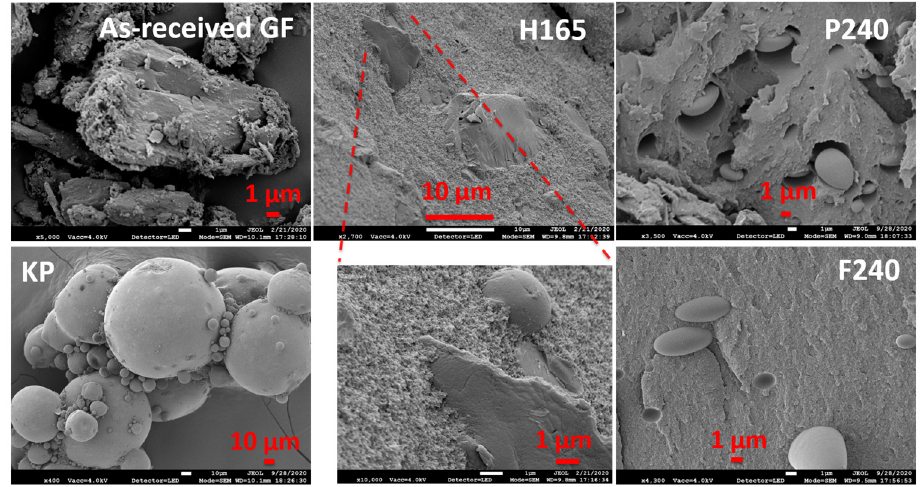
Figure 4. SEM images of as-received GF, KP powders, filament (H165), 3D printed tablet (F240) along with 3D printed placebo tablet (P240).